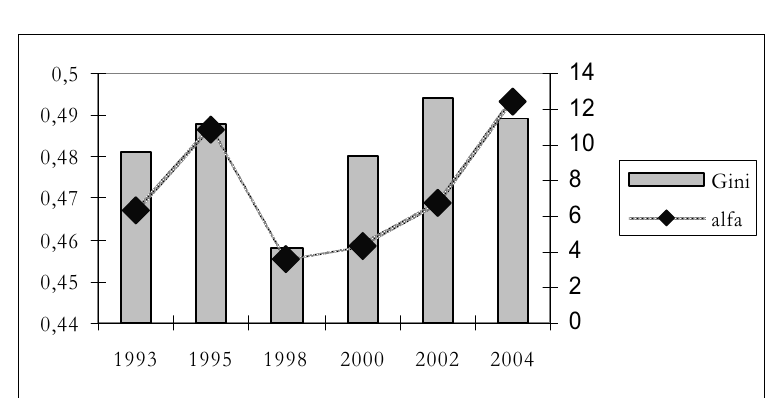
Figure 3 – Dagum model for human capital in Italy from 1993 to 2004, Gini index and 3 parameter.